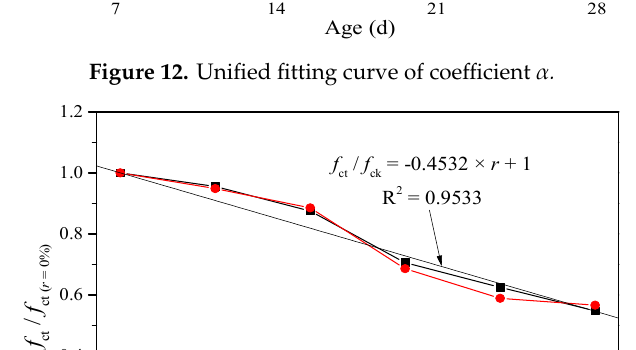
Figure 12. Unified fitting curve of coefficient α.